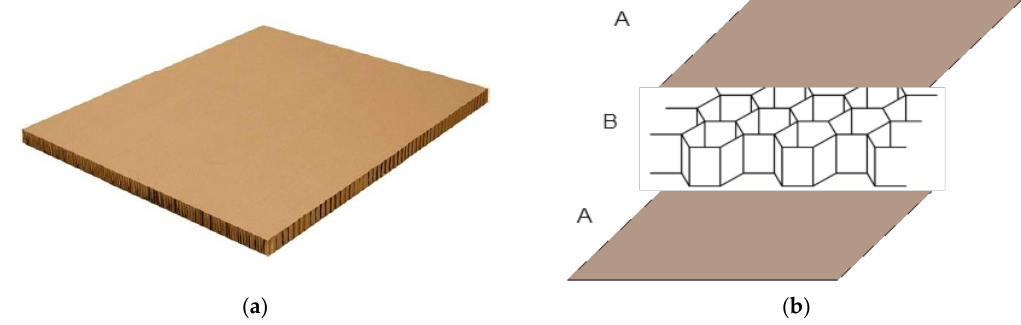
Figure 1. Analysed honeycomb paperboard ( a ) and construction of a cellular cardboard with a honeycomb core ( b ).